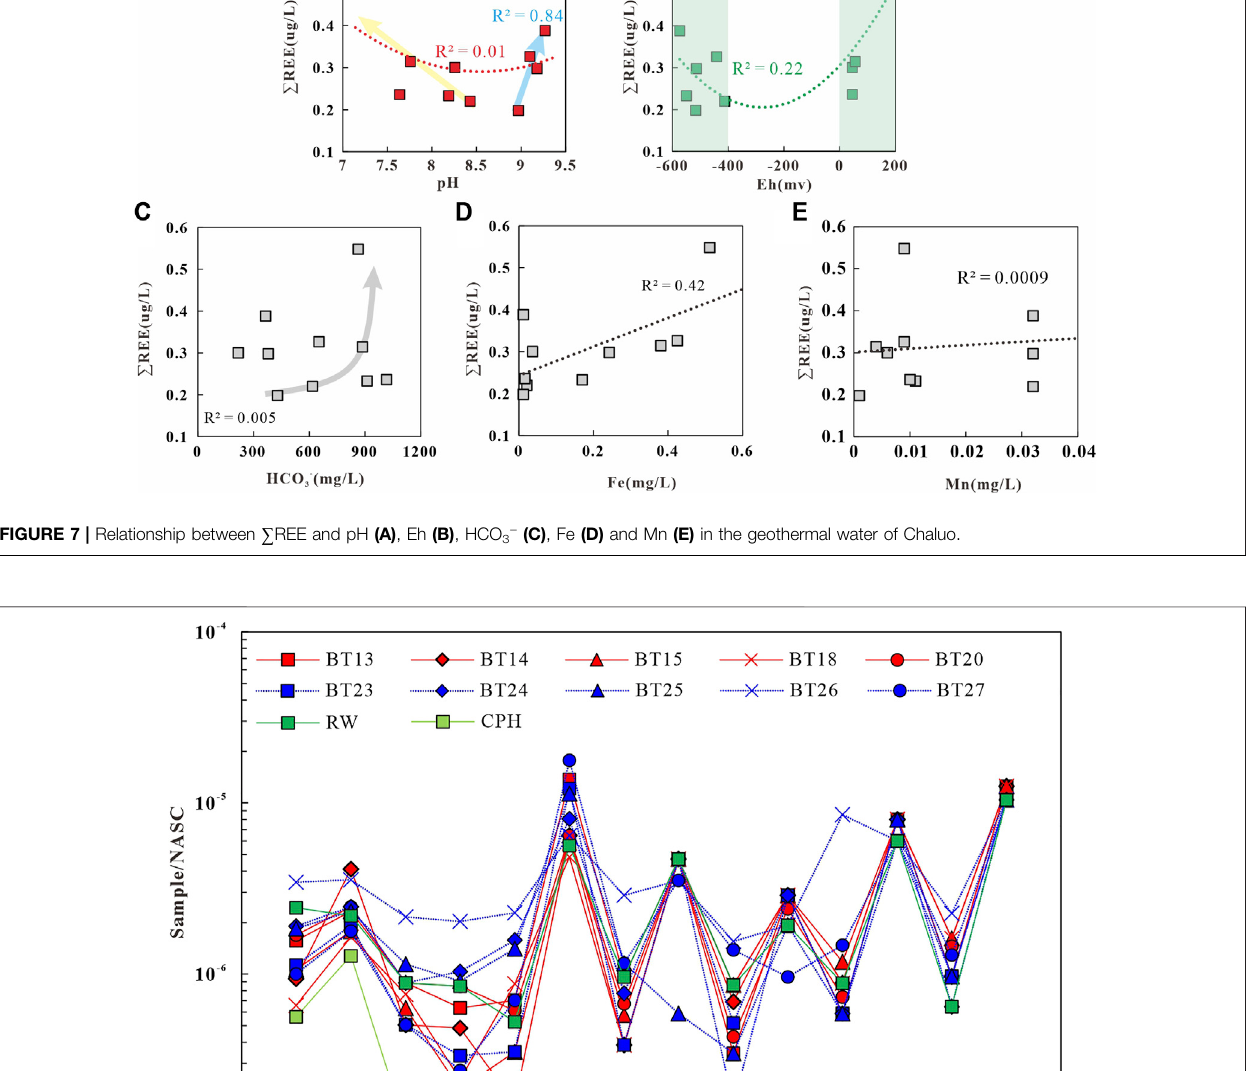
Frontiers in Earth Science |